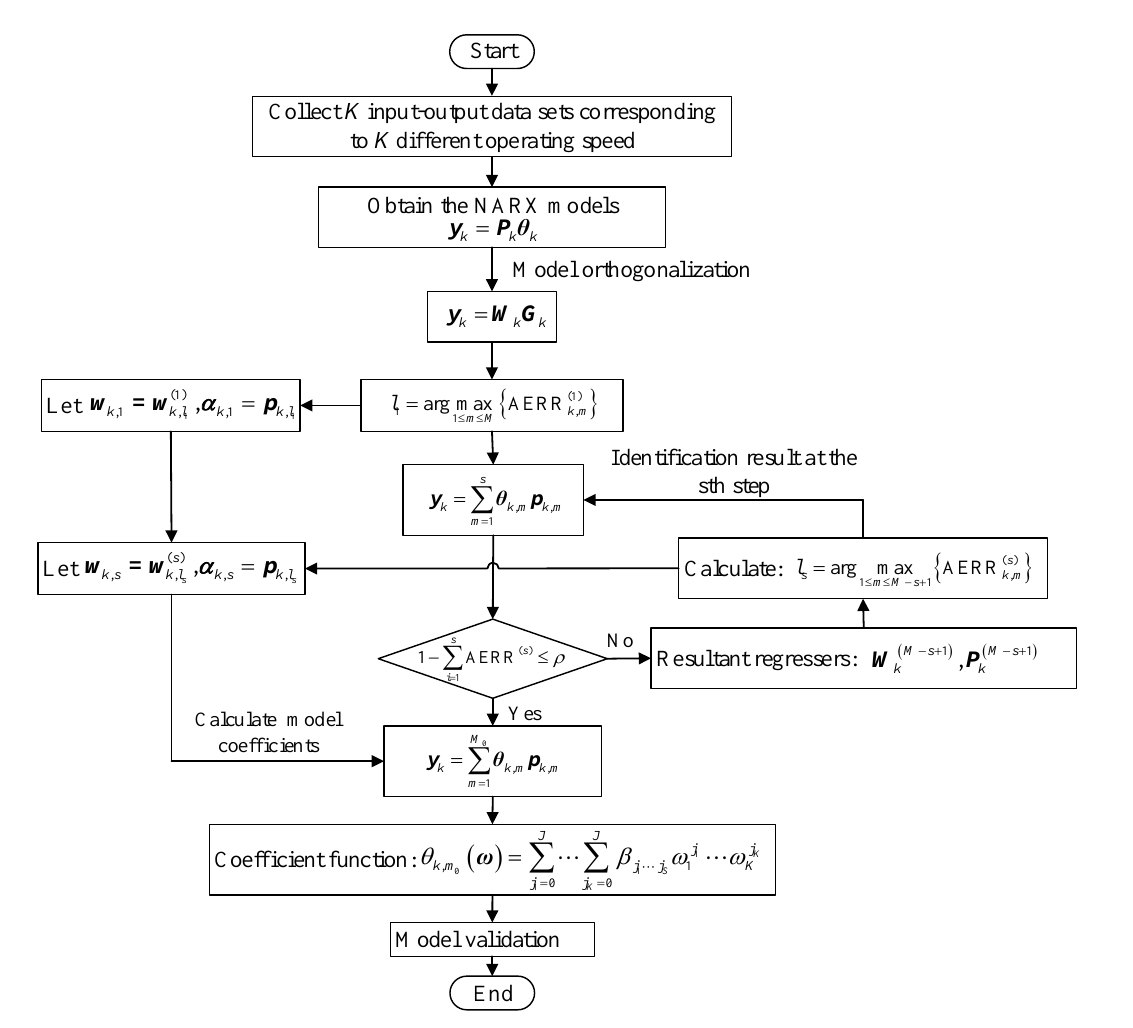
Figure 7. Modeling process for rotor system by using the proposed method.